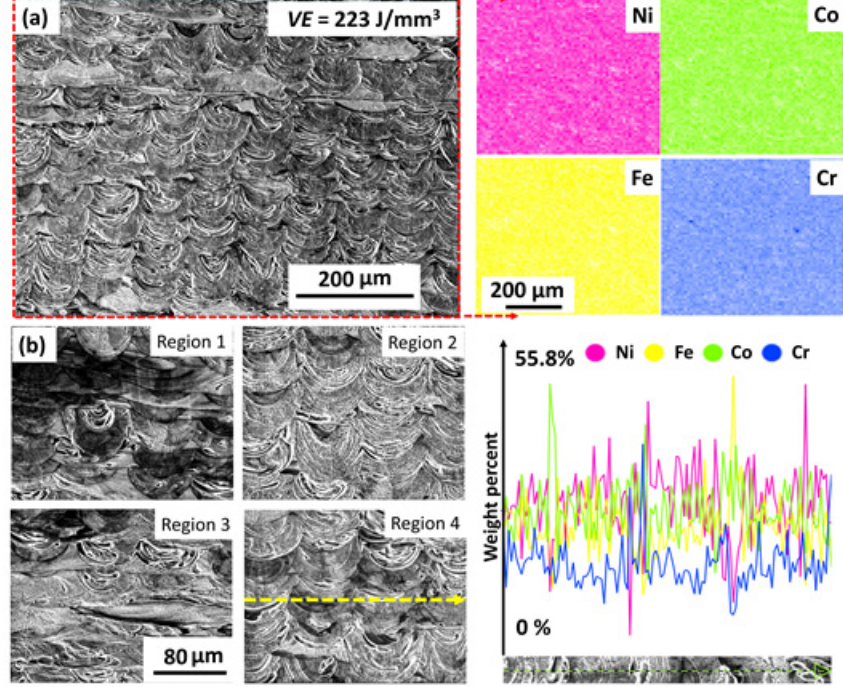
Figure 7. SEM image and EDS (energy dispersive spectroscopy) scanning results of HEE1 (elemental powder sample): ( a ) EDS scanning map, ( b ) four microregion morphologies and EDS scanning line result.